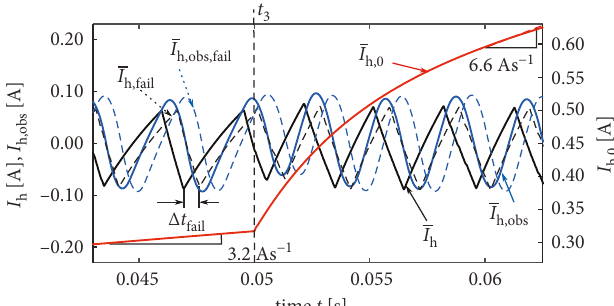
Figure 9: Behavior of magnetizing current in case of dynamic change of d and encourages transformer saturation. The controlled observer current I cycle d 1 zero. I varies in phase due to model failure in L h , obs , fail